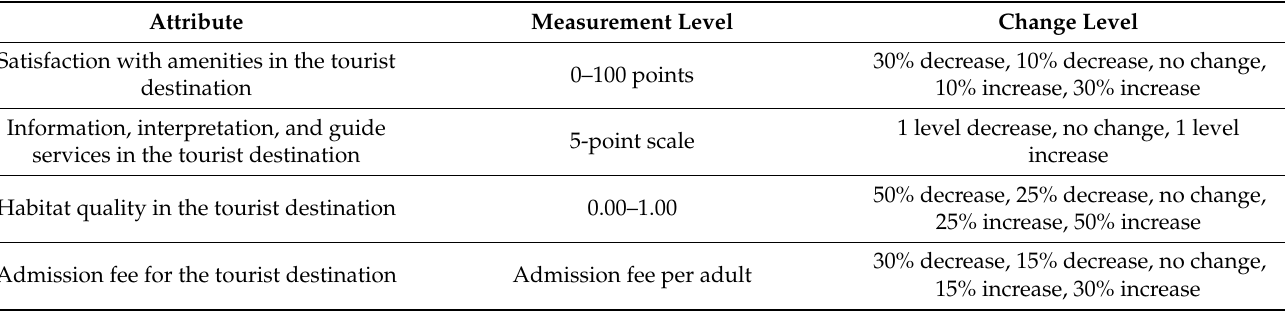
Table 1. Attributes related to ecotourism, measurement level, and change level.